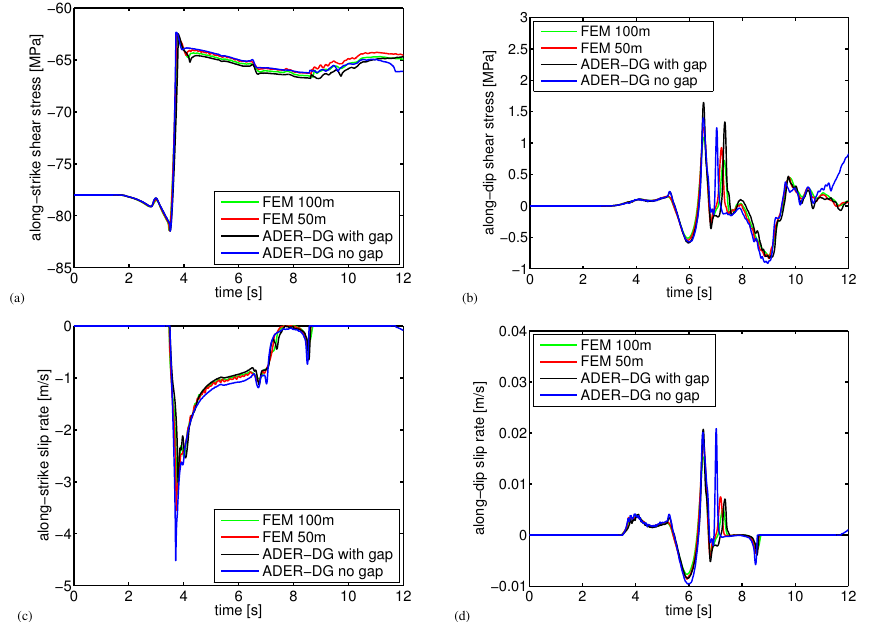
Fig. 10. Shear stresses and slip rates for TPV15 on the branch fault at 9 km along-strike and 7 . 5 km depth. ADER-DG solutions are shown in black (with gap) and blue (without gap), the FEM comparison solutions in red ( 50 m discretization) and green ( 100 m discretization).